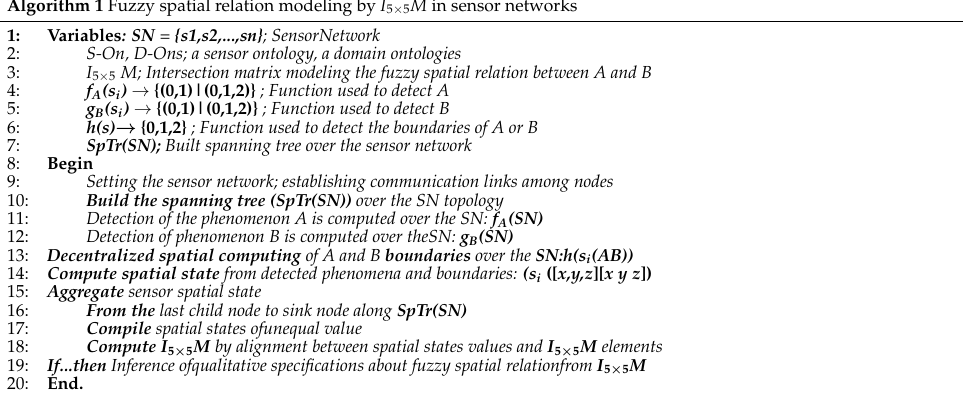
Algorithm 1 Fuzzy spatial relation modeling by I 5 × 5 M in sensor